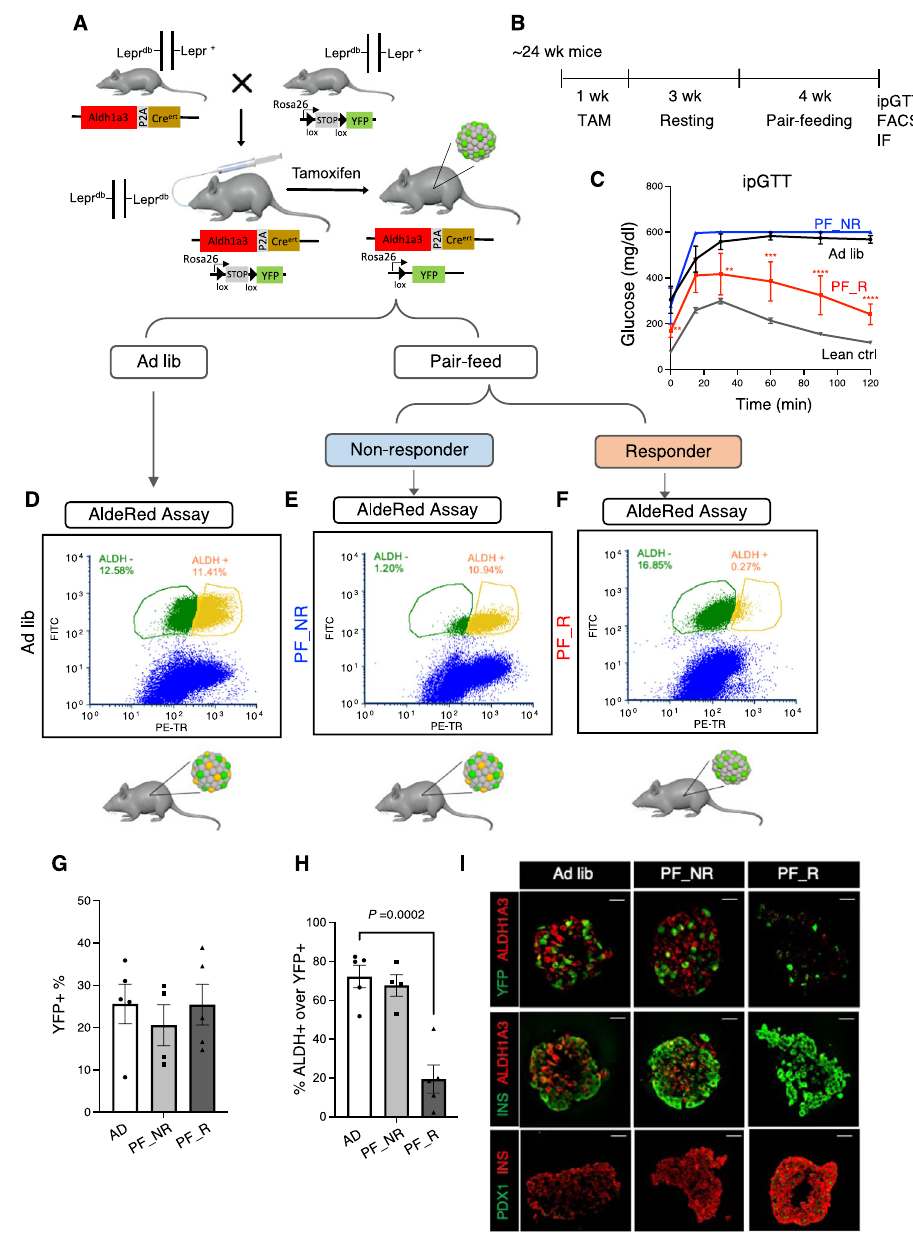
Fig. 1 | A+ β -cellsare converted toA – β -cells.A Generationof Aldh1a3-Cre ert :YFP fl /+ db/db mice and tracing of A+ cells in db/db mice during pair-feeding. B Schematic drawingoftheexperimentalprocedure. C IPGTTafter4weeksofpair-feeding( n =6, 5, 4 or 10 for ad lib, PF_R ( Pair-fed responder) , PF_NR ( Pair-fed non-responder) or lean mice. Data are expressed as means±SEM. Two-way ANOVA with multiple compar- isontestwasusedforstatisticalanalysis.The P valuewas0.0097,0.0077,0.0002for timepoints 0, 30, or60min and P <0.0001for90and 120minincomparisonofad lib with PF_R. * P <0.05, ** P <0.01, *** P <0.001, **** P <0.0001. D – F FACS to detect